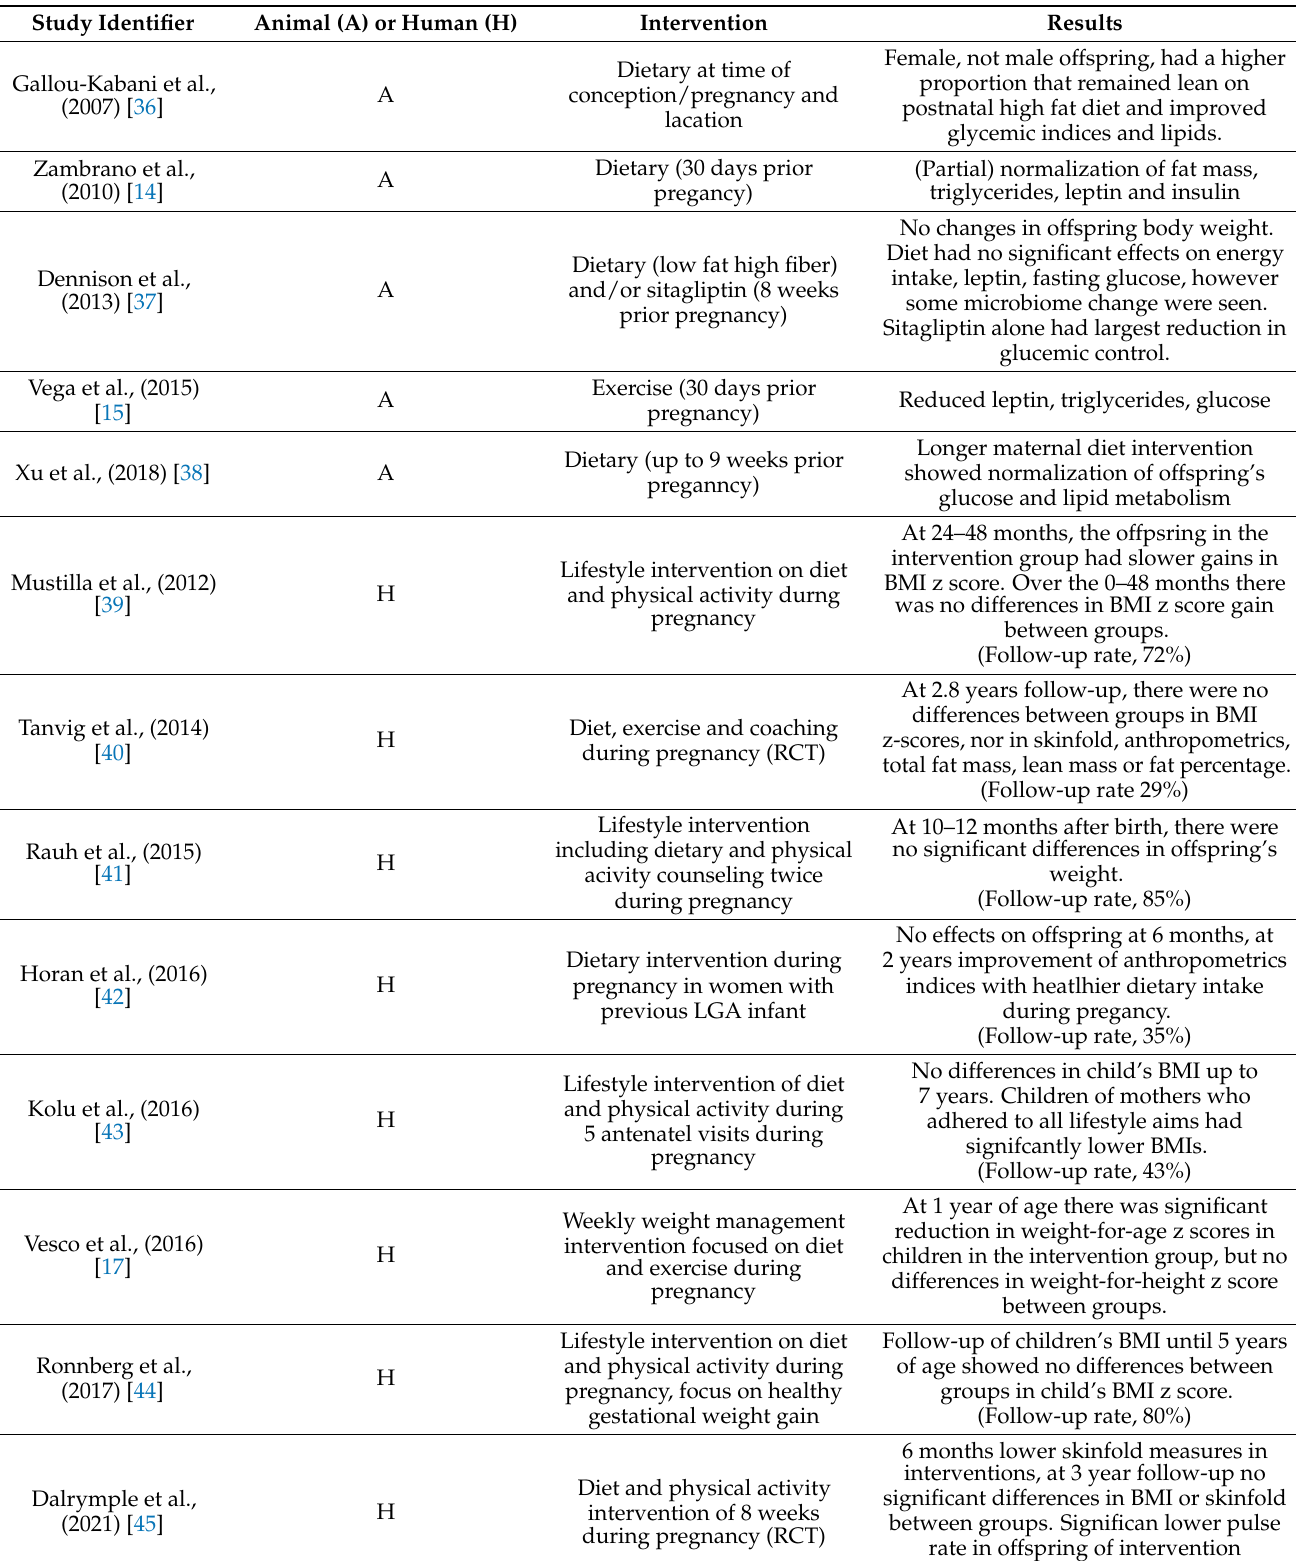
Table 3. Summary of selected current (pre-)pregnancy lifestyle intervention studies in animal